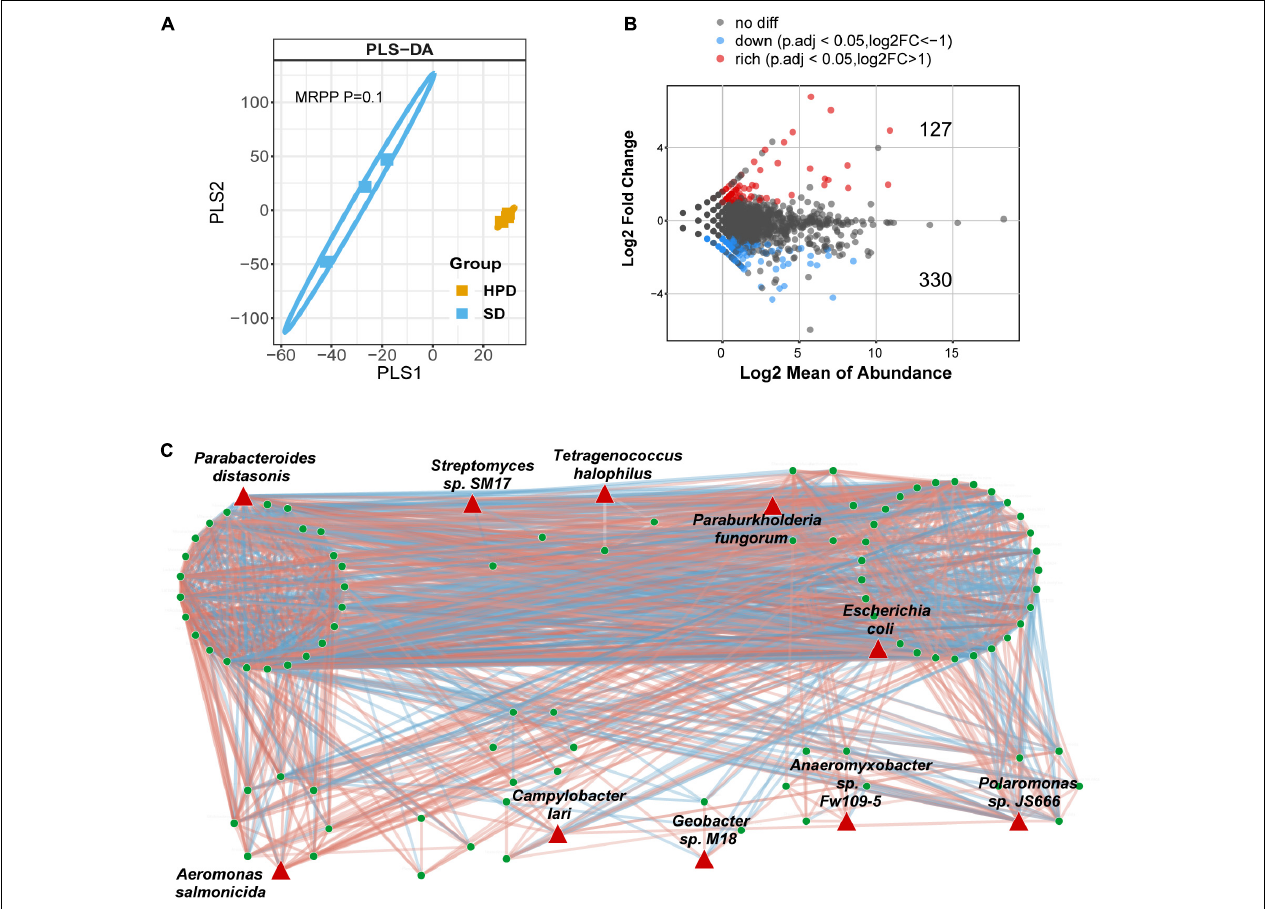
FIGURE 2 | Alteration of intestinal microbial structure in mice fed a high protein diet. (A) PLS-DA analysis based on the relative abundance of species reflects the between-subjects ( β ) diversity across groups, in which the orange circles and blue squares represent HPD and SD groups, respectively (MRPP, P = 0.1). (B) Volcano plot demonstrates the differential abundance of species between HPD and SD groups. ANCOMBC is used to calculate the P-values. Points are colored according to the number of log2FC if they passed significance thresholds. (Adjusted P < 0.05, adjustment using FDR). (C) The microbial co-occurrence network where different nodes indicate different species is constructed. Red links indicate positive covariation between two individual nodes, whereas blue links indicate negative covariation. The hub species are marked by red